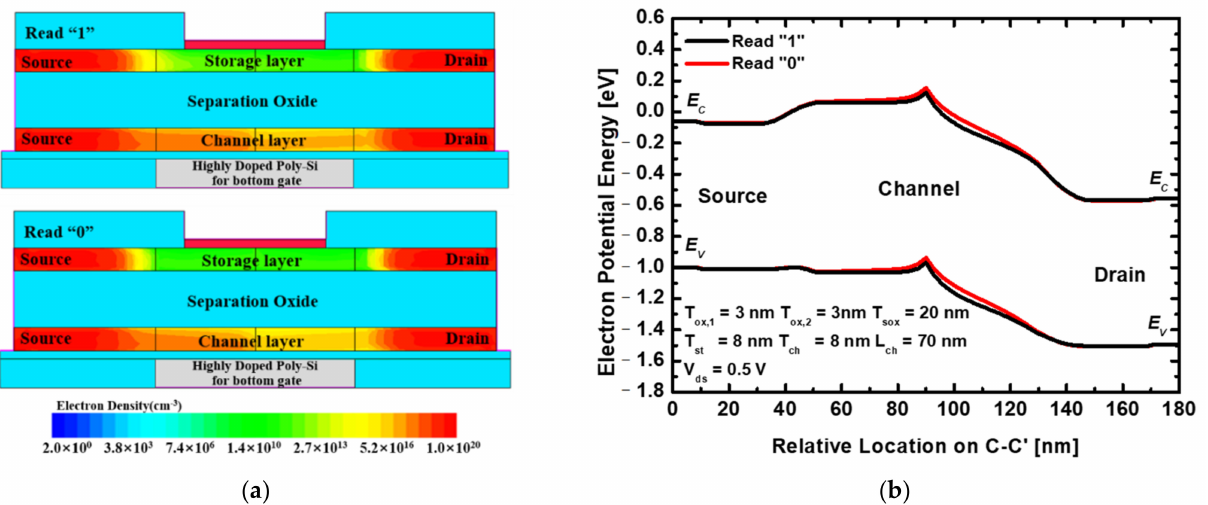
Figure 7. ( a ) Simulation profile of the proposed 1T-DRAM during the read operation showing electron density. ( b ) Energy band diagram of the channel layer during the read operation. The energy band is extracted at 2 nm above the bottom gate